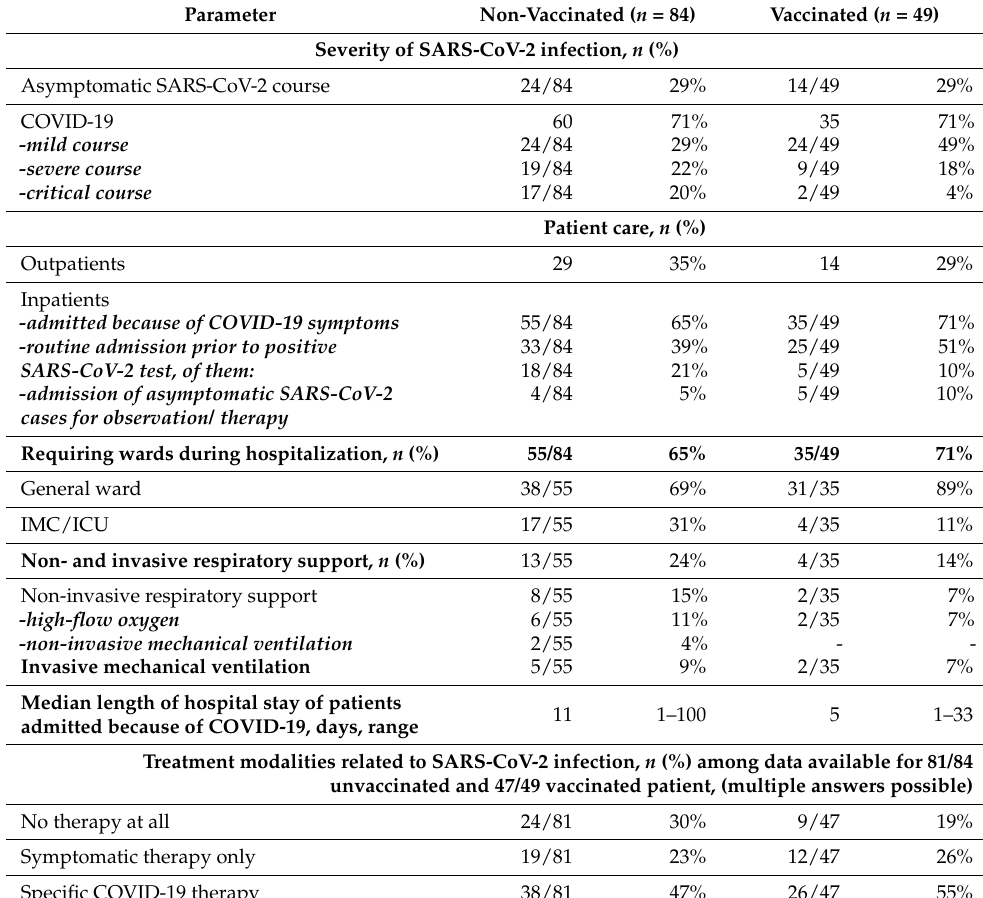
Figure 1. Clinical, diagnostic, and treatment aspects of COVID-19 course among non- and vaccinated cancer patients of the study. Table 3. Outcomes of SARS-CoV-2 infection in 133 cancer patients. n , number; IMC, intermediate care; ICU, intensive care unit; PD, progressive disease; FU,